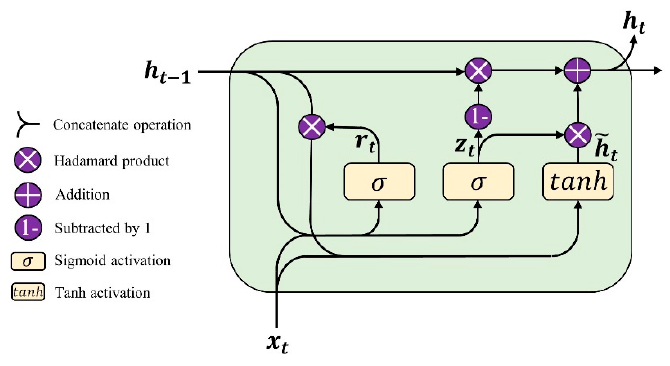
Figure 2. The structure of a basic GRU cell.